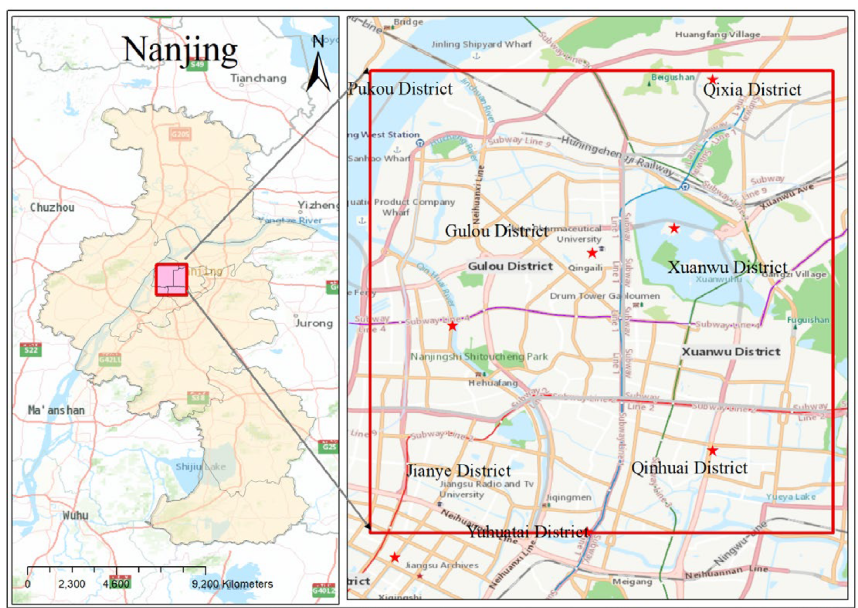
Figure 1. Model domain of the PALM simulation used in the study for the city of Nanjing. The size of the model domain is approximately 10km × 10km. Map credit: ESRI 2020.